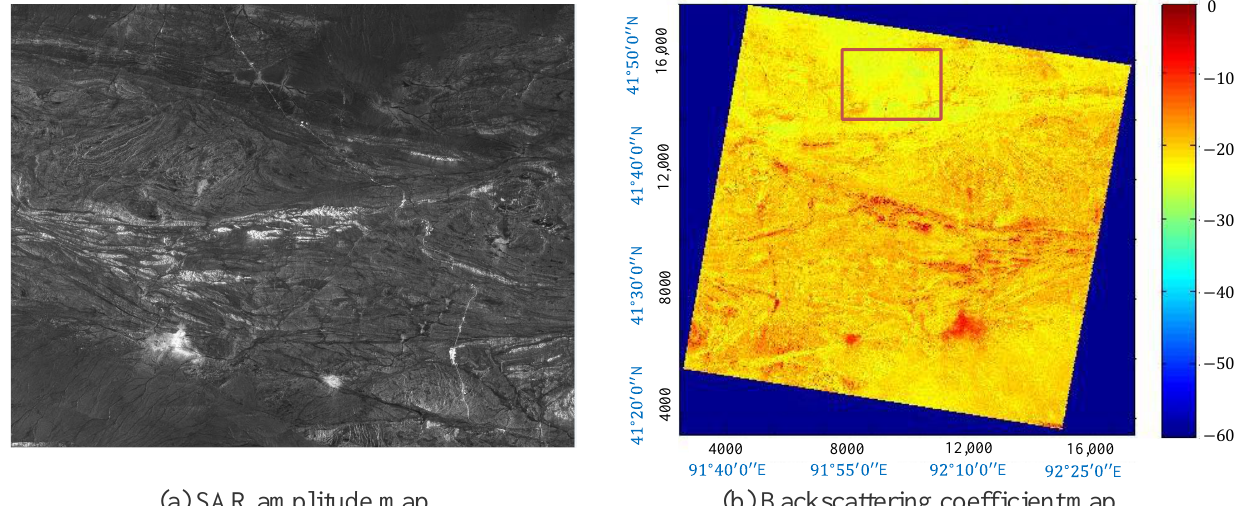
Figure 5. ( a ) The attitude map of the test site. ( b ) backscattering coefficient map of the test site.